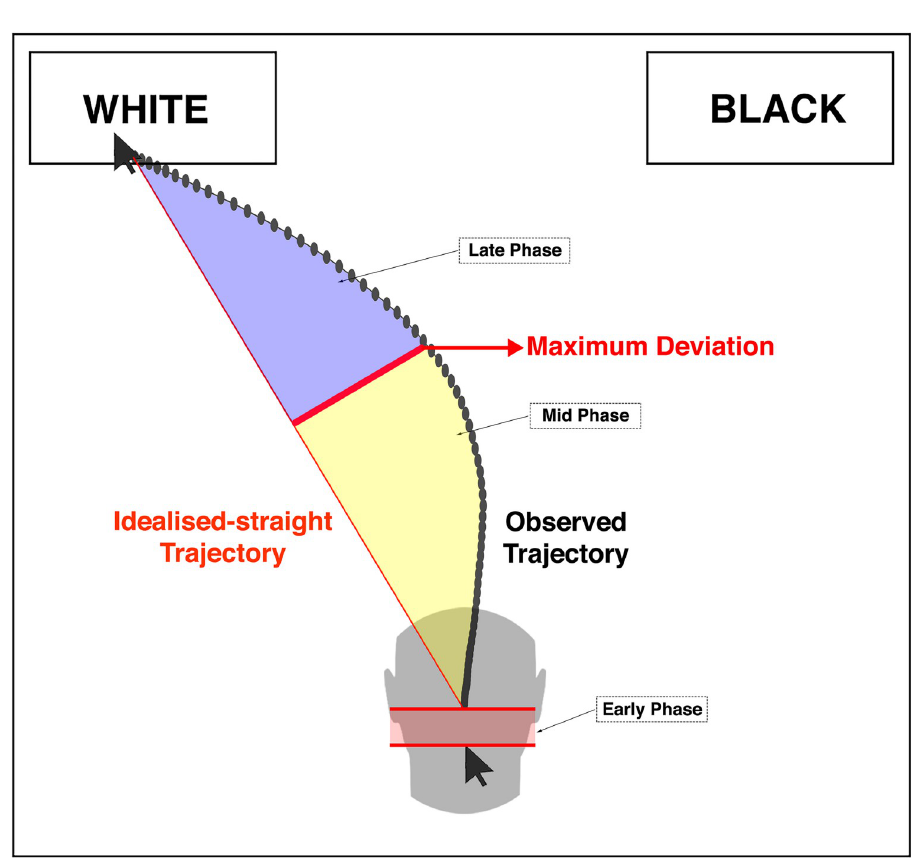
Fig 2. Representative illustration of the temporal unfolding of a typical trial of MT-race-IAT. The Early Phase (the latency from stimuli presentation and the onset of mouse movements) would mainly correspond to the activation of the automatic responses elicited by stimulus processing. According to Erb’s proposal [29], the decision conflict between automatic and controlled responses would start here, while reaching its apex at the point of highest attraction towards the incorrect response (namely the Maximum Deviation in an MT trial). The latency needed to achieve that highest attraction from the beginning of mouse movement corresponded to the mid-phase. Following the conflictual apex, progressively controlled motor corrections would allow reaching the target. The latency needed to achieve the target response from the conflictual apex was used to obtain the Late Phase.